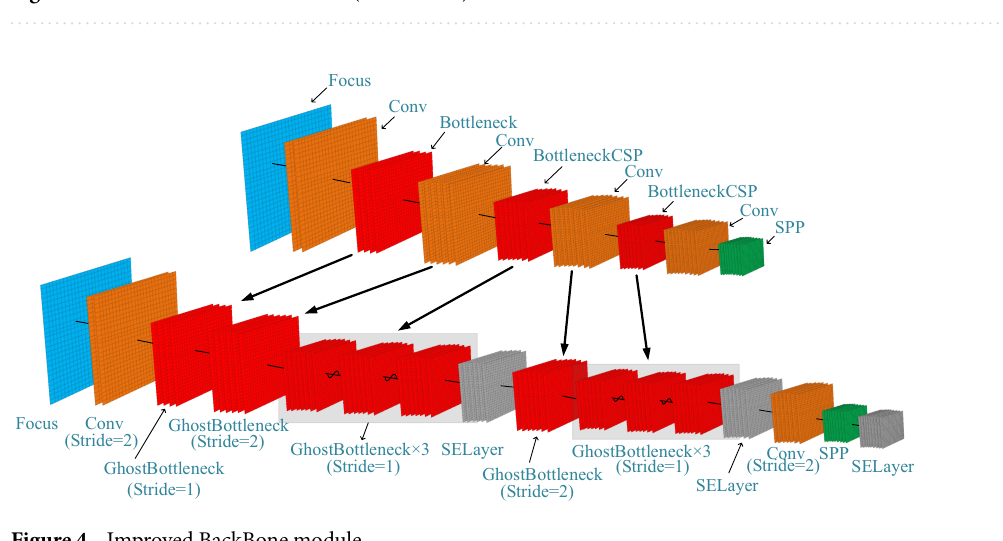
Figure 4. Improved BackBone